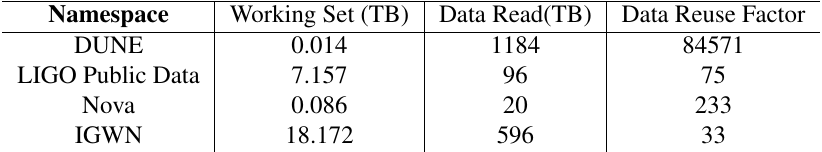
Figure 5. Geographical location of the Stashcache infrastructure Table 1. Namespace usage from (September 2019 to February 2020) of the Stashcache infrastructure, data obtained from GRACC